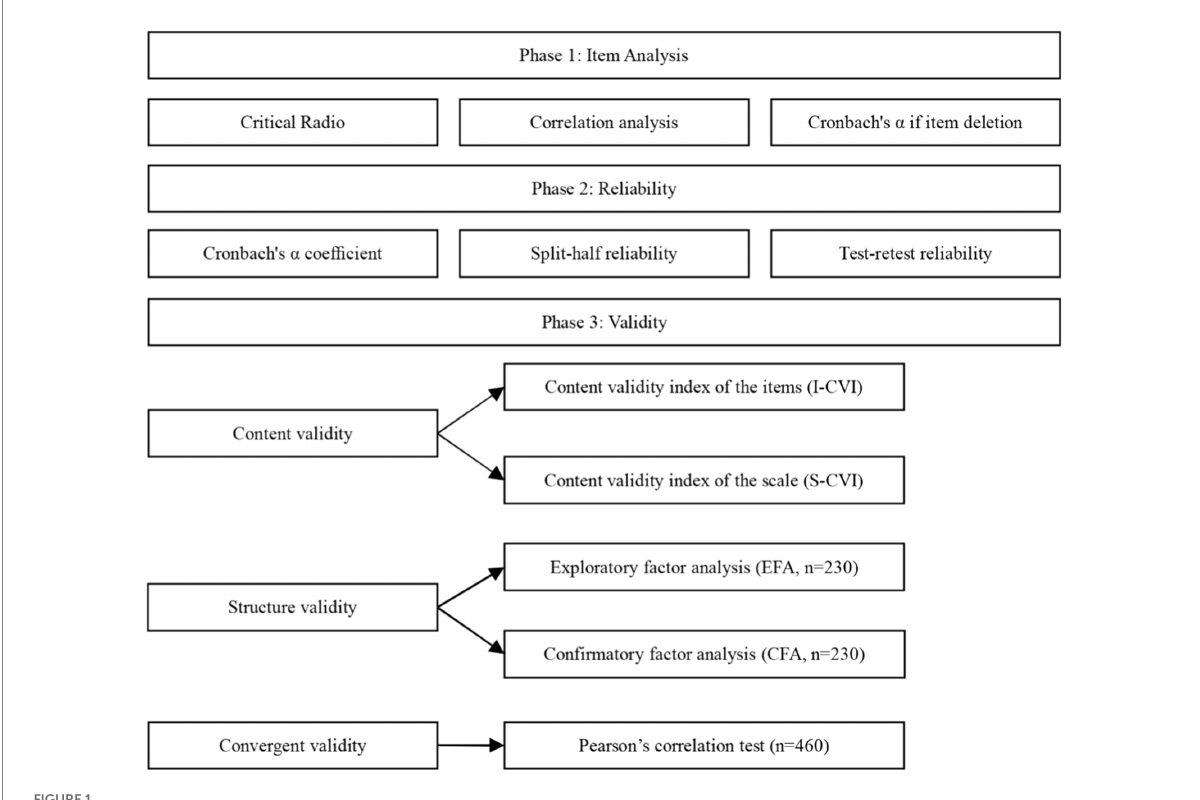
FIGURE 1 The data analysis procedure for Chinese version of the